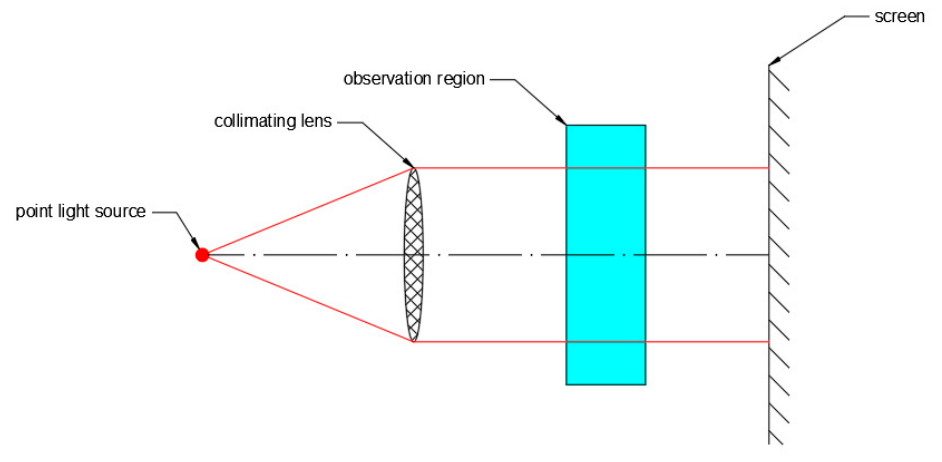
Figure 12. Basic shadowgraph layout.